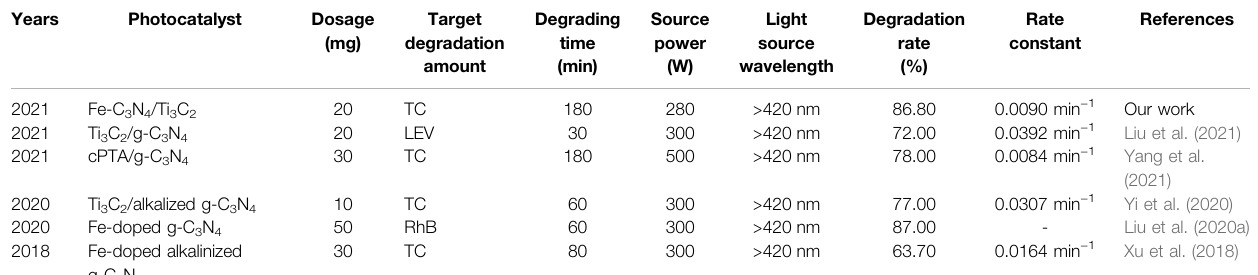
TABLE 2 | Comparison of photocatalytic properties of different